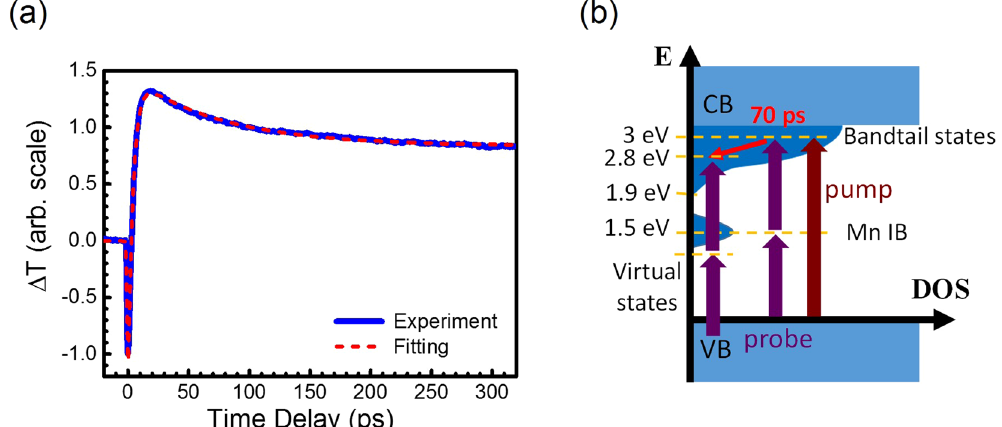
Figure 5. ( a ) The transient transmission changes of the probe pulses through Mn-doped GaN with concentrations of 1.2 × 10 20 cm − 3 . The pump/probe energy is 3.0/1.5 eV (410/820 nm). ( b ) The schematic diagram illustrates the carrier dynamics in the bandtail states monitored by the two-photon absorption of the 1.5 eV probe pulses. The monitor efficiency is dramatically reduced when the intermediate states become virtual states for two-photon